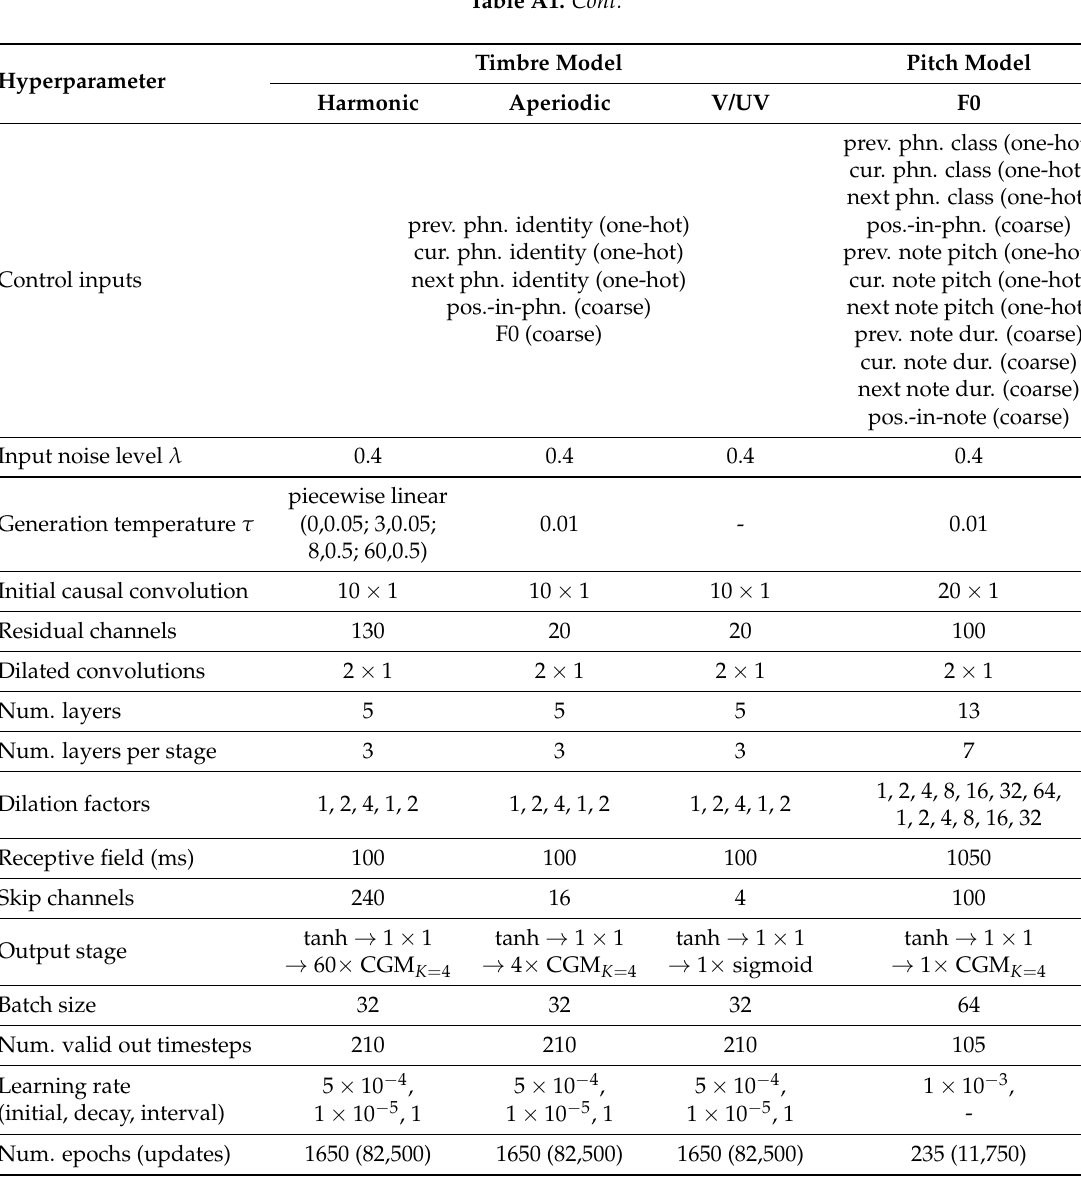
Table A2. Hyperparameters for timing